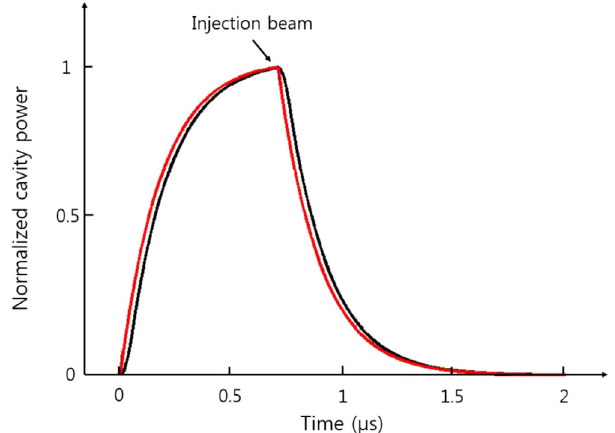
FIG. 4. Lattice functions for